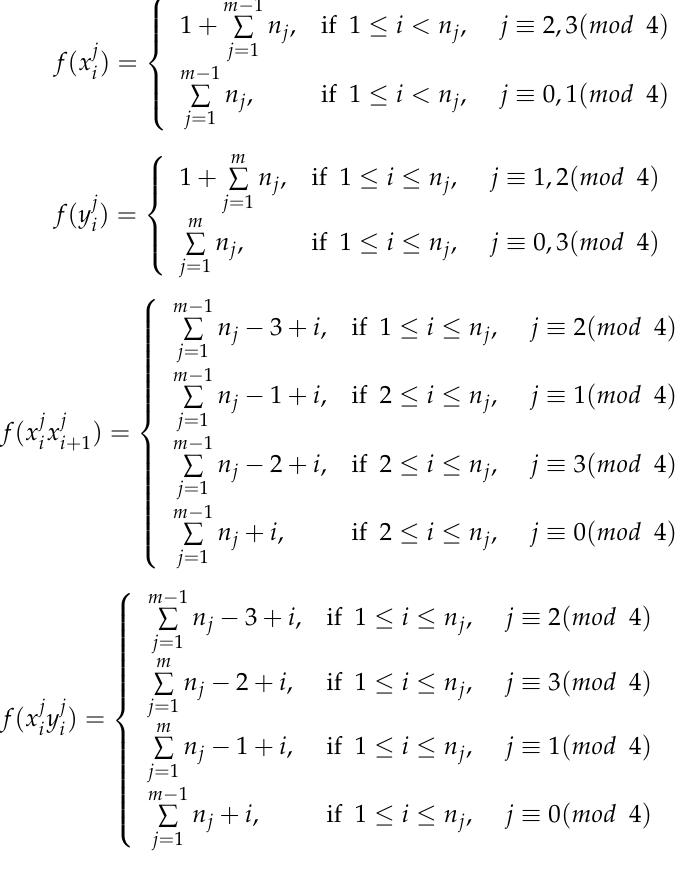
and ( b ) The edge weights for D 1 3